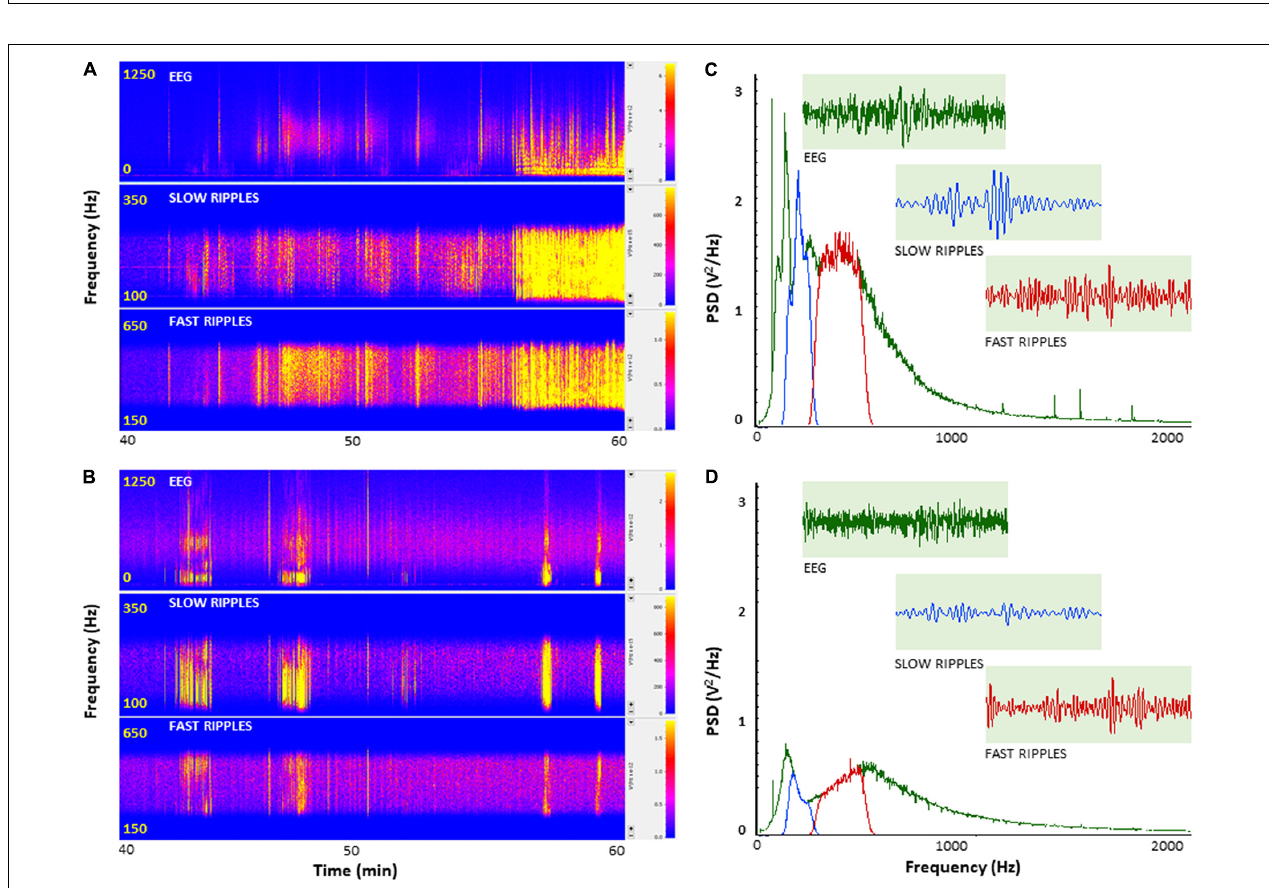
FIGURE 2 | Insulin selectively depresses cortical ripples in PH-Tau-Tg mice brains. PSDs analysis of field potential recordings from prefrontal cortex after KA injection. FFT of population spikes and filtered high frequency oscillations (HFO): slow ripples 125–250 Hz and fast ripples 250–500 Hz are shown in (C,D) with representative traces (inserts). The power density of field potentials and filtered frequencies were converted into heat maps (A,B) , Controls and PH-Tau-Tg mice, respectively). (A,B) Are representative heat maps of intracerebral recording, slow ripples and fast ripples from a control mouse (A) and PH-Tau-Tg mouse (B) . (C,D) Are FFT of PSDs obtained from pooled data of controls ( n = 3) and PH-Tg mice ( n = 3) respectively.